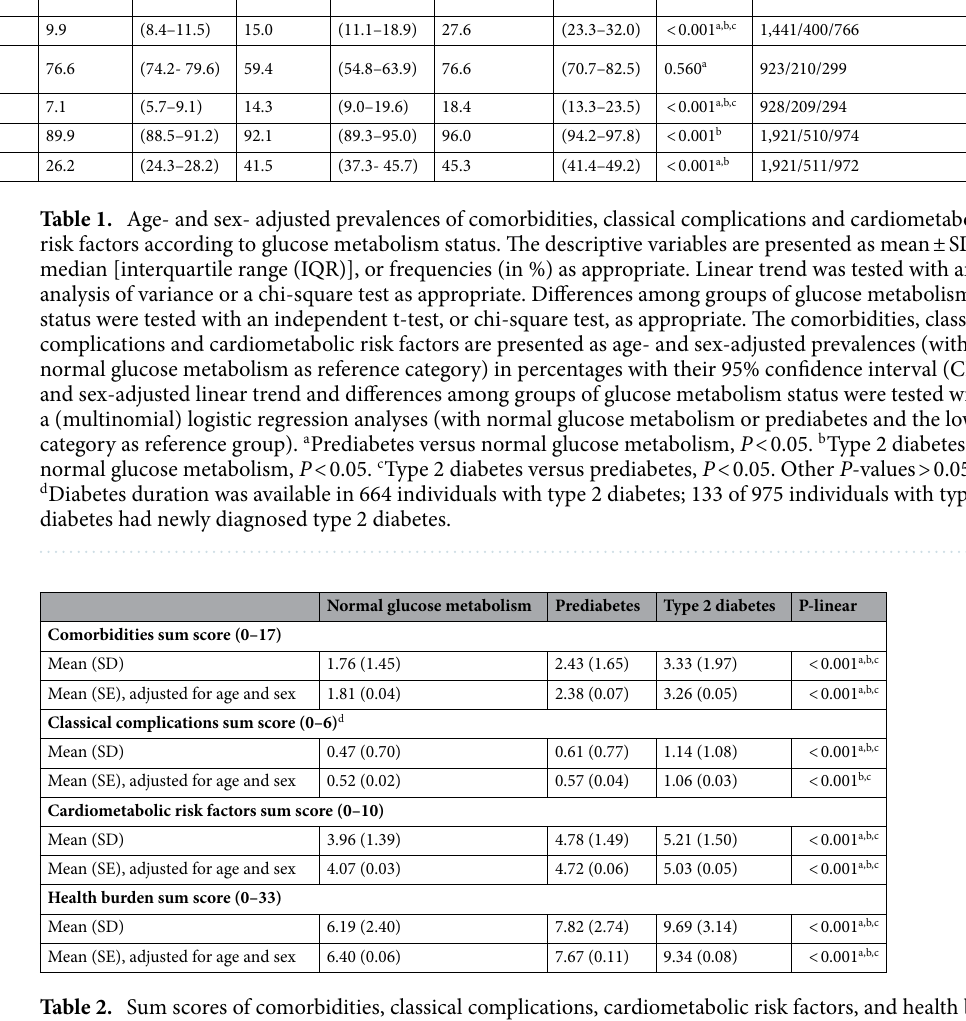
Table 2. Sum scores of comorbidities, classical complications, cardiometabolic risk factors, and health burden according to glucose metabolism status. N = 3,410; 1,924/511/975. Data are presented as mean (standard deviation) or adjusted mean (standard error). Crude linear trends and differences in sum scores among groups of glucose metabolism status were tested with an analysis of variance or an independent t-test as appropriate. Age-and sex-adjusted mean values (standard error) were calculated with an analysis of covariance. Age- and sex-adjusted linear trends and differences in sum scores among groups of glucose metabolism status were tested with linear regression analyses. a Prediabetes versus normal glucose metabolism P < 0.005; b Type 2 diabetes versus normal glucose metabolism P < 0.001. c Type 2 diabetes versus prediabetes P < 0.05.